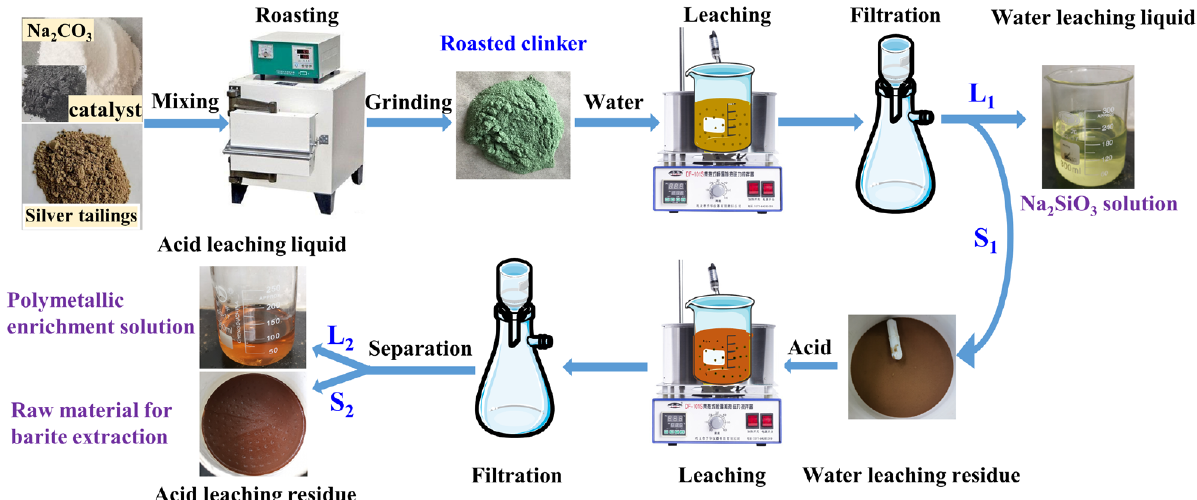
Figure 2. The leaching experimental process of silver tailings’ roasted clinker.